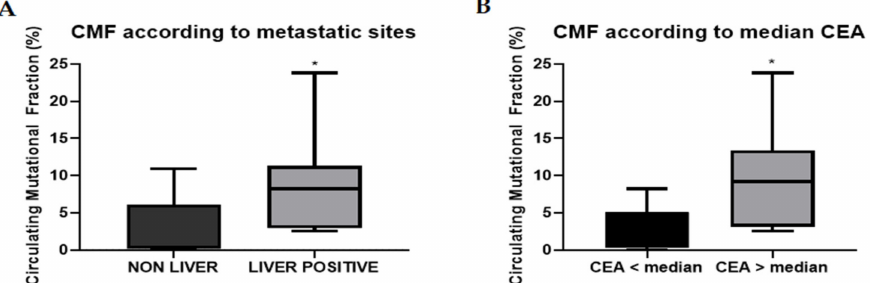
Figure 2. Circulating mutational fraction (CMF) distribution between clinical subgroups. ( A ) Di ff erence between NON-LIVER (5 pts) and LIVER POSITIVE (9 pts) metastatic colorectal cancer (mCRC) ( p = 0.0385). ( B ) Di ff erence between patients with baseline CEA levels below (7 pts) or above (7 pts) median ( p = 0.0469). *: p < 0.05. NON-LIVER: patients with no evidence of liver metastases. LIVER POSITIVE: all the patients with at least one liver metastasis (the sum of LIVER ONLY and LIVER and